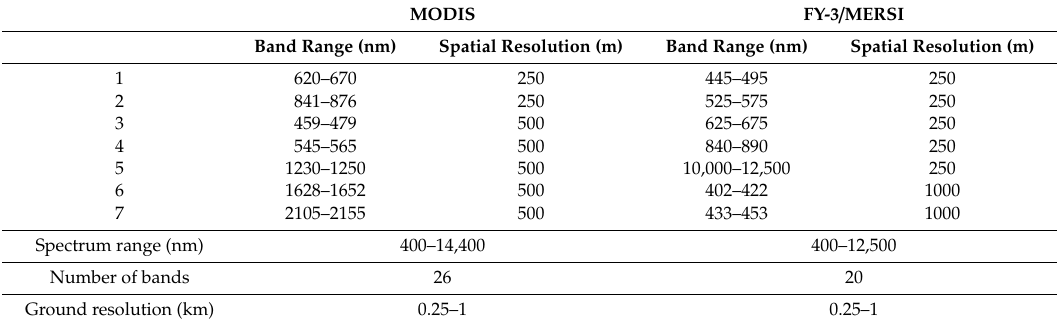
Table 1. Parameters of moderate resolution imaging spectroradiometer (MODIS) and Fengyun 3 medium resolution spectral imager (FY-3 /